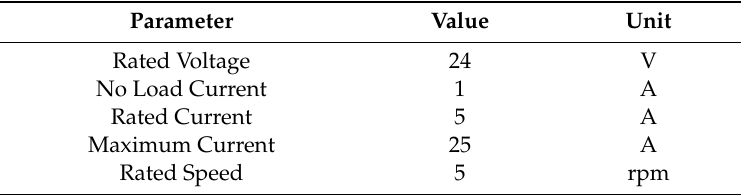
Table 2. Parameter of the DC